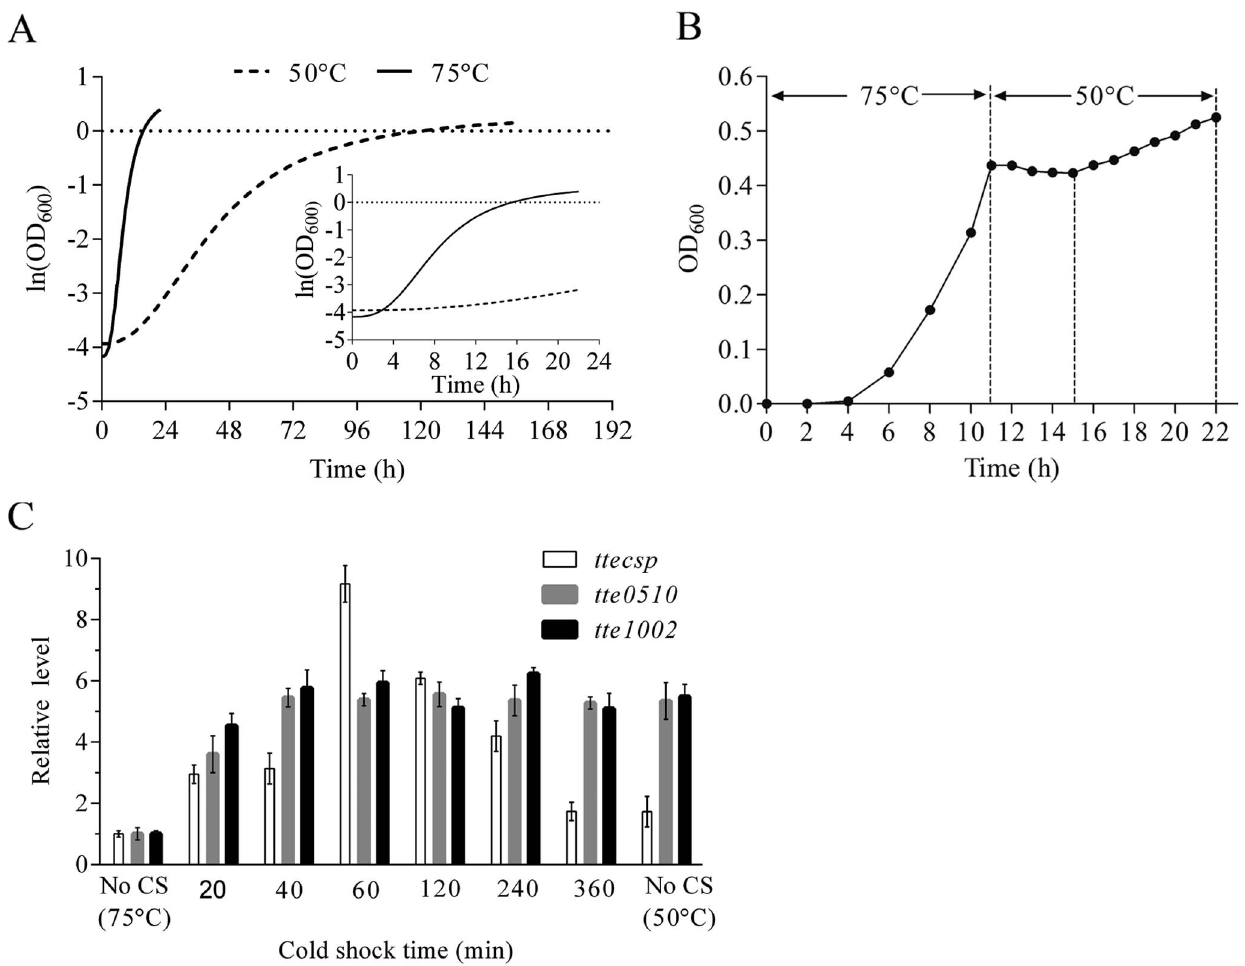
Figure 1. Cold shock response profile of T.tengcongensis . A. Growth profiles of separate cultures maintained at 75 u C and 50 u C. B. Growth profile following rapid temperature shift from 75 u to 50 u C. C. Transcription profiles of ttecspC , tte0510 and tte1002 following cold shock. Cells were grown at 75 u C to an OD 600 of 0.6, then cold shocked at 50 u C for the indicated times. Control cultures (No CS) were grown constantly at 75 u or 50 u C. The data are shown as means 6 SD (n=3).